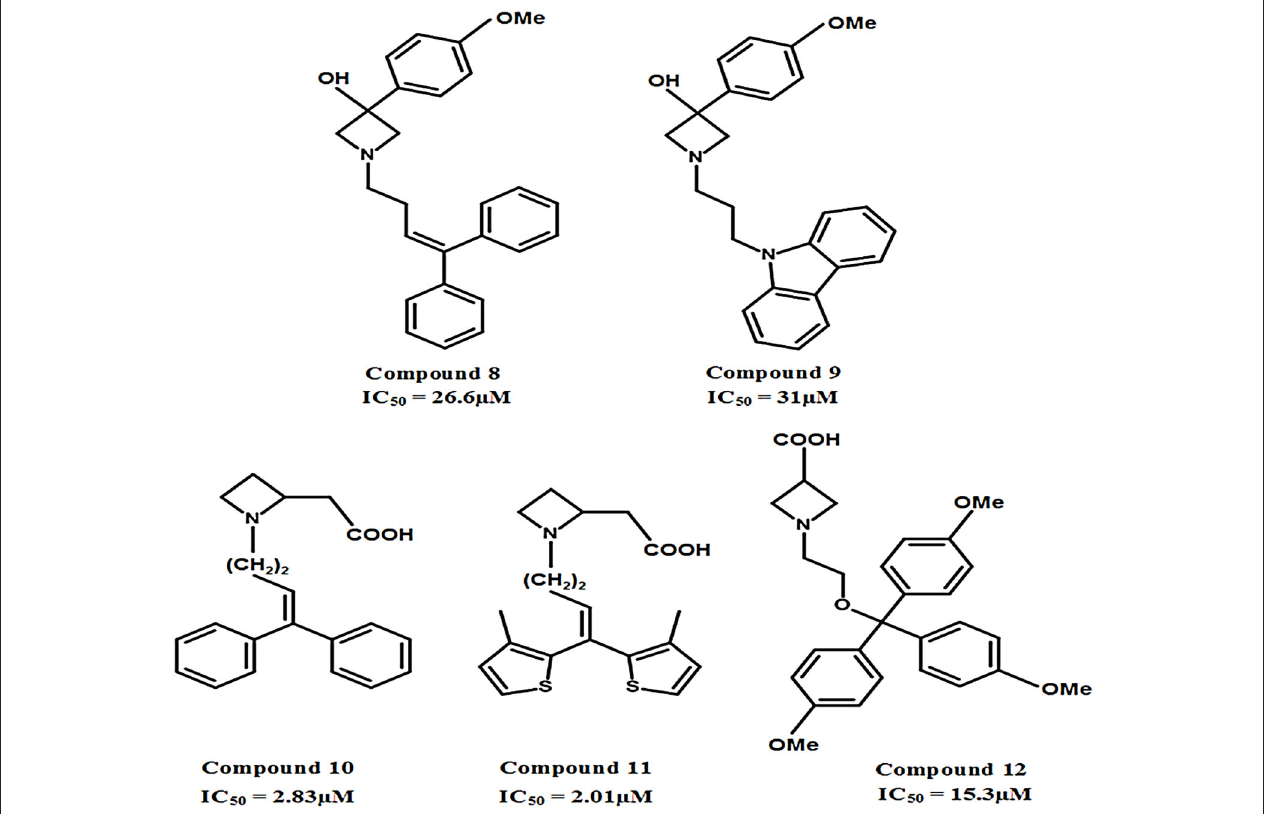
FIGURE 11 | Chemical structures of azetidine derivatives as modulators of hGAT1. Compounds 10 and 11 were shown to be the most potent with respect to the other compounds in the series.